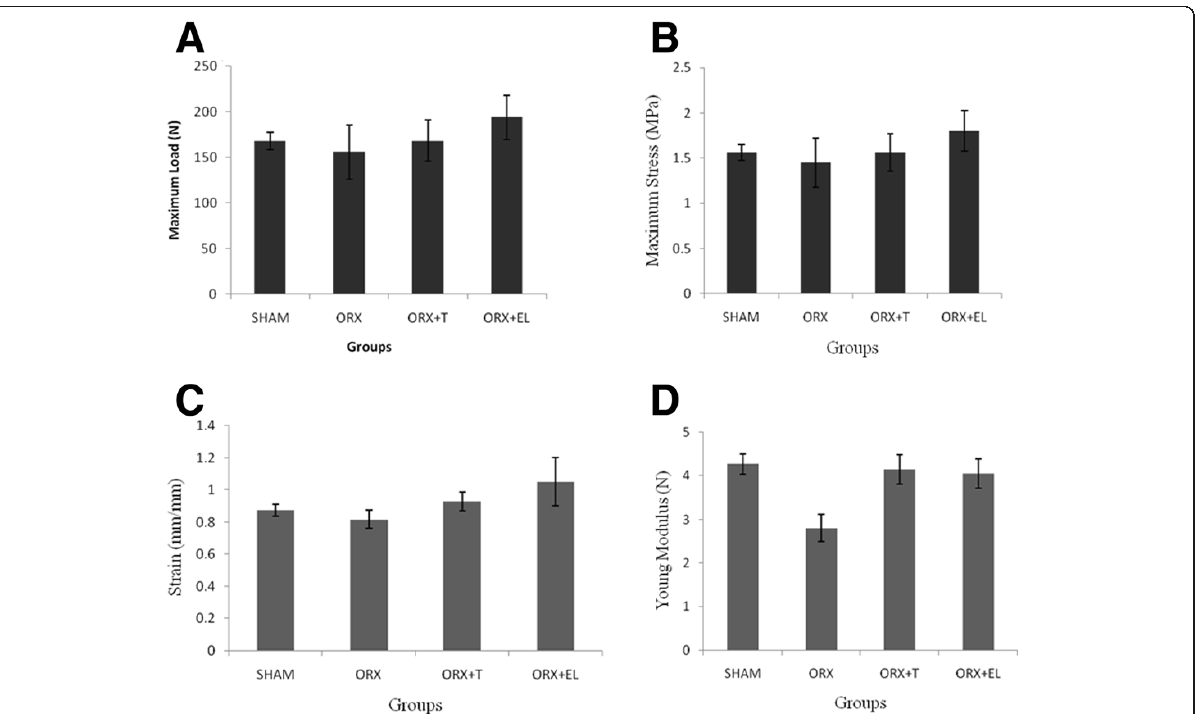
Figure 4 A, B, C and D: The Load, Stress, Strain and Young Modulus for all the groups. Data were presented as mean ± SEM with significant difference p < 0.05. SHAM : Sham- operated group. ORX : Orchidectomized control group. ORX + T : Orchidectomized group treated by testosterone. ORX + EL : Orchidetctomized group treated with